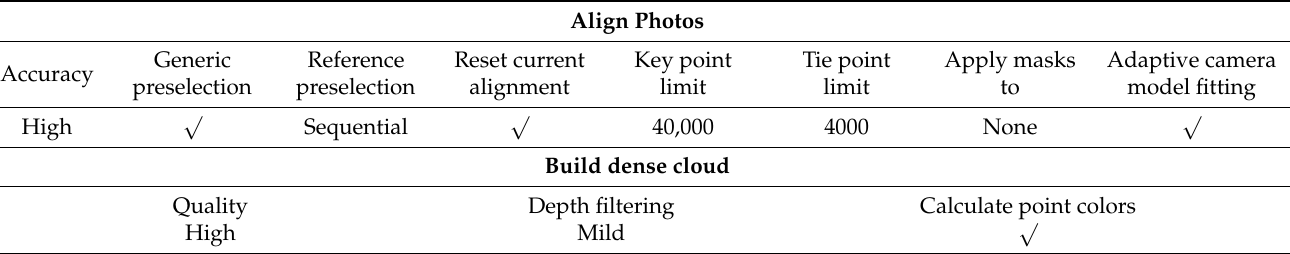
Table 5. Settings of the processes in the Agisoft software. Align